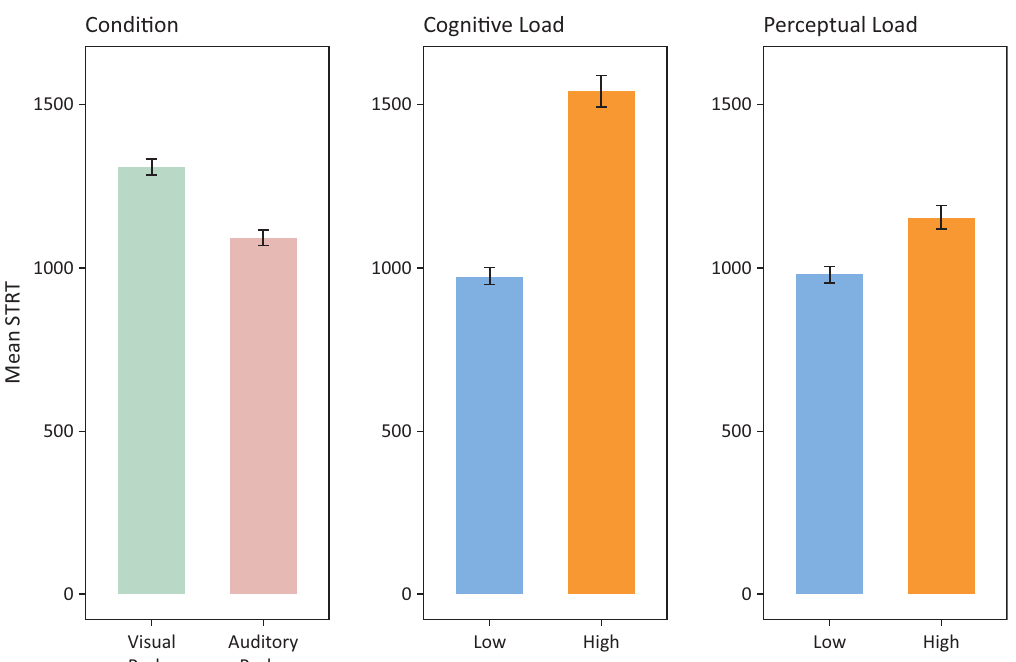
Figure 3. Main effects for condition, cognitive load, and perceptual load. Cognitive load and perceptual load are each compared to a control condition containing neither the cognitive load nor the perceptual load manipulation. Error bars represent 95% confidence intervals.